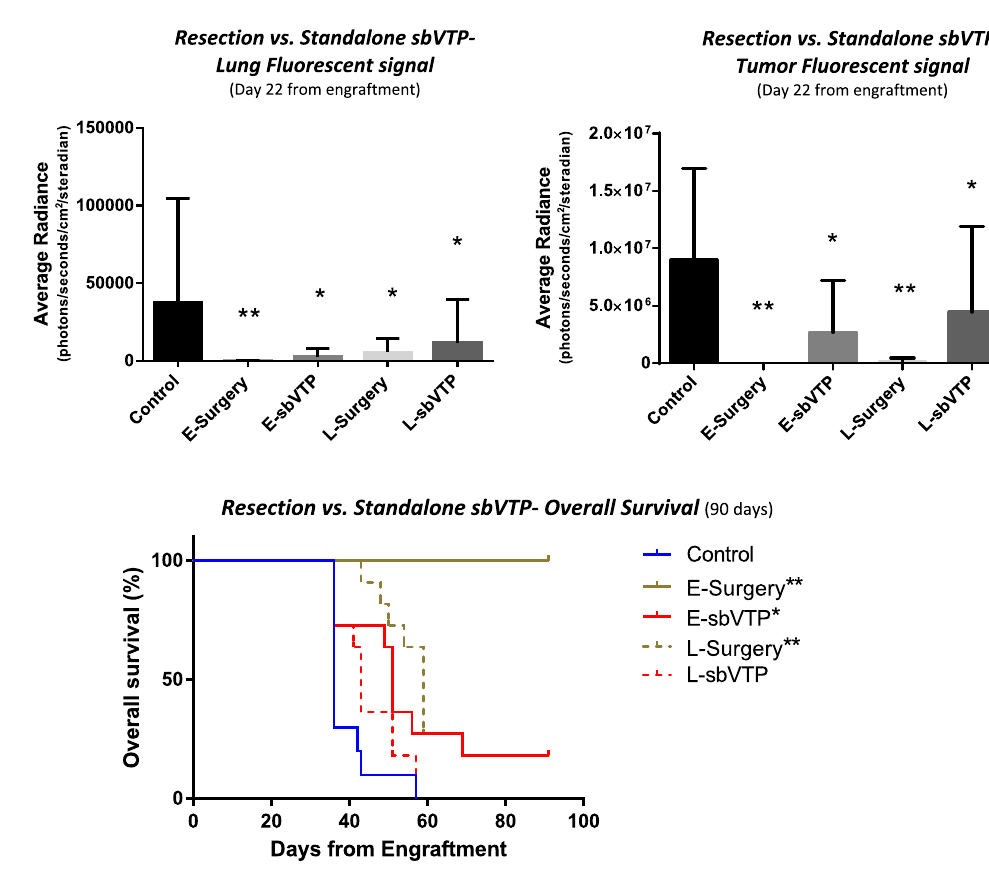
Figure 1. (Upper panel) Fluorescence signal from thorax and the primary tumor implant site in mice injected with MB-49 urothelial cancer cell line ( n = 54). (Lower panel) Kaplan–Meier curves showing overall survival. Animals were treated with surgery or sbVTP, 2 or 3 weeks (early or late, respectively) after tumor injection, compared to control group ( n = 11 per treated groups, n = 10 per control). E-sbVTP early sub-ablative vascular- targeted-photodynamic therapy, E-Surgery early tumor surgical resection, L-sbVTP late sub-ablative vascular- targeted-photodynamic therapy, L-Surgery late tumor surgical resection. * P < 0.05 as compared to control; ** P < 0.0001 as compared to